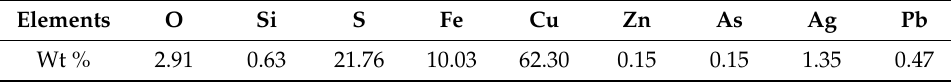
Figure 1. X-ray powder diffraction analysis of bornite. Table 1. Chemical composition of the bornite.